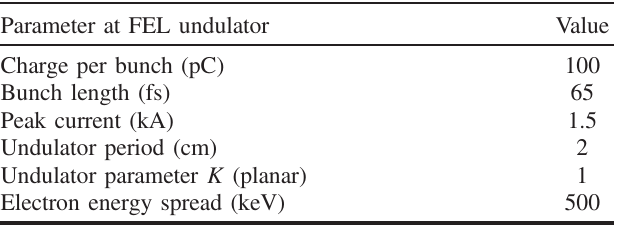
TABLE II. Parameters assumed at the FEL